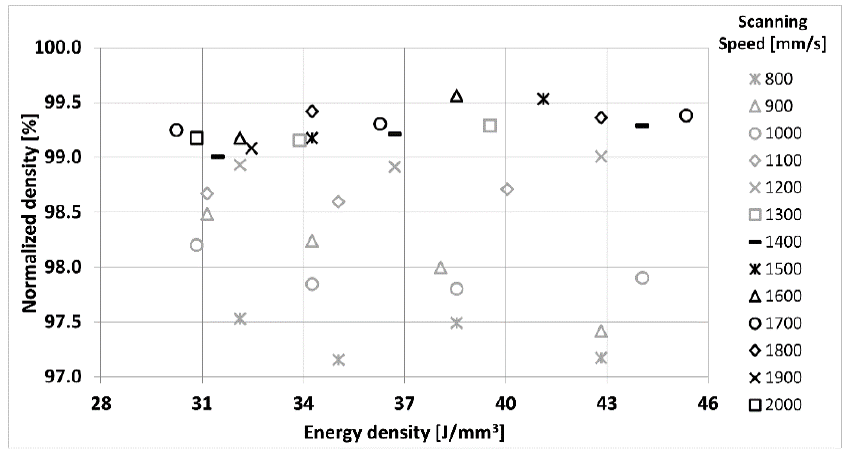
Figure 5. Relative density measurements with Archimedes method in relation to the energy density incident on the powder bed.